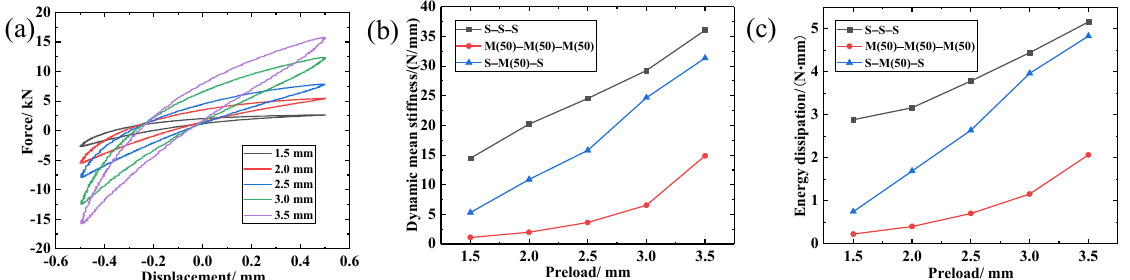
Figure 17. Dynamic performance of LCDS under different preloads: ( a ) Hysteresis loops under different preloads; ( b ) Variation of dynamic mean stiffness under different preloads; ( c ) Variation of energy dissipation under different preloads.